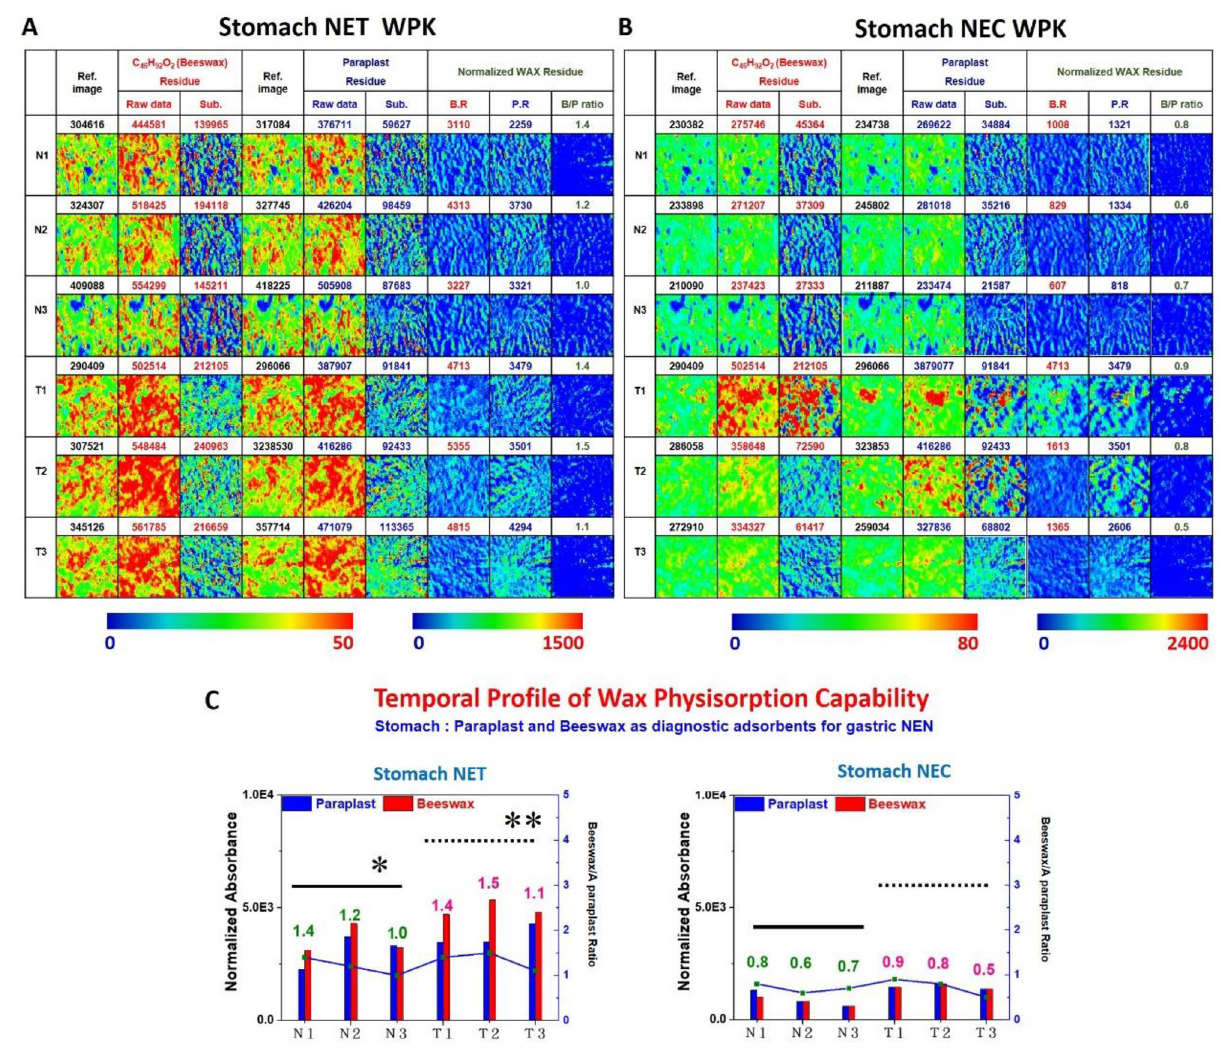
Figure 5. ( A , B ) The WPK-FTIR images of the wax remnant and ( C ) the quantitative results in gastric NET and NEC. A significantly higher ratio of the beeswax-to-paraplast remnant of gastric tissue was observed in the benign area of NET G1 compared with NEC G3 (*p = 0.018, solid line). A higher ratio of the beeswax-to- paraplast remnant of tumor cells in NET G1 than that in NEC G3 was also found (**p = 0.024, dotted